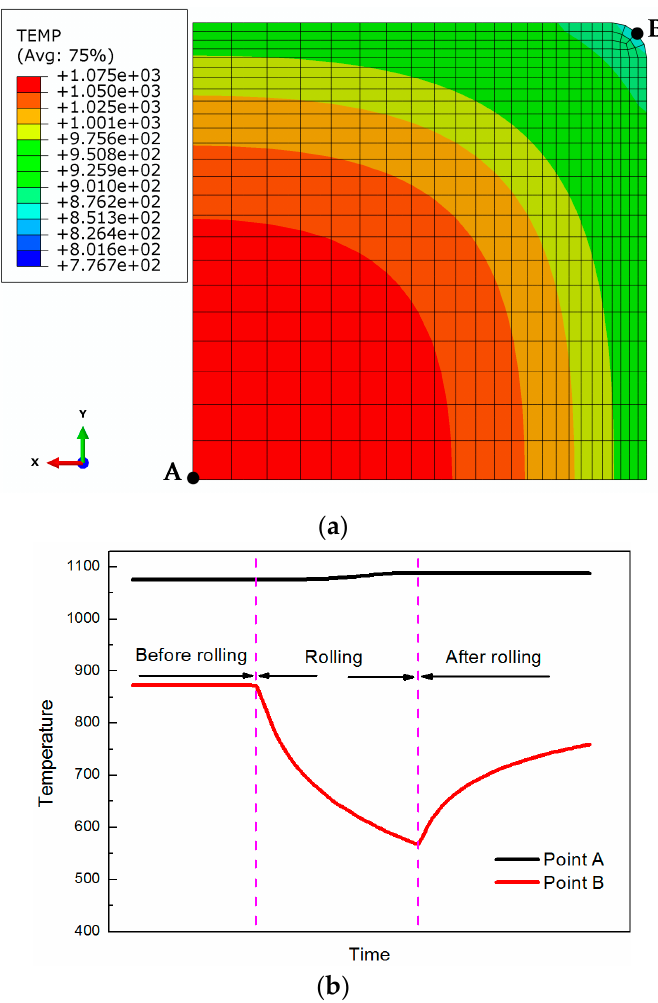
Figure 8. Temperature change at different position of the billet. ( a ) The location of the chosen point A and B. ( b ) Temperature history in the corner and edge of the billet.